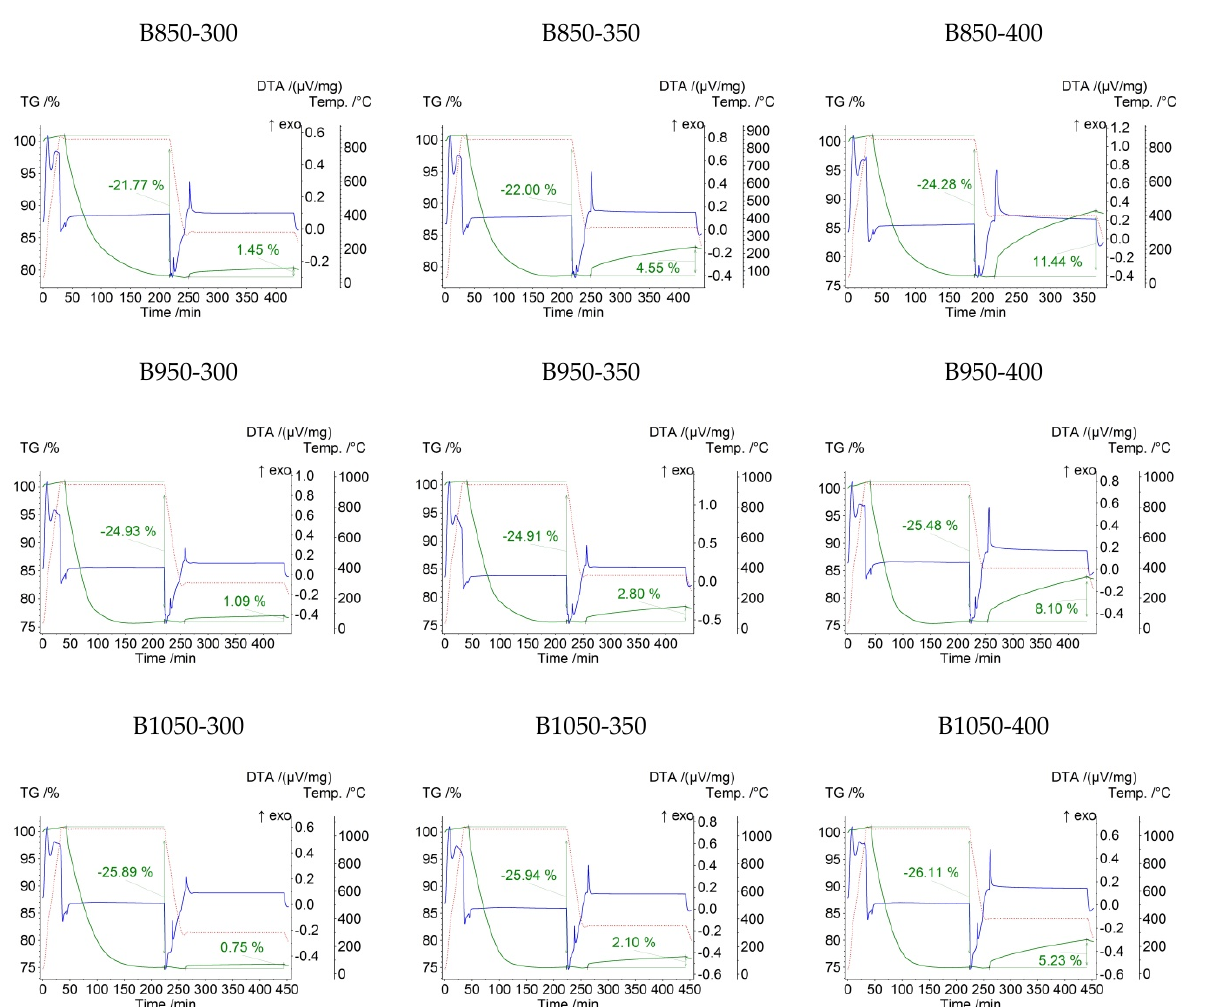
Figure 7. TG/DTA curves recorded during the thermal analysis of ground mill scale (fraction B) subjected to reduction (carbon monoxide) at 850 °C, 950 °C, and 1050 °C, followed by exposure to an oxidizing atmosphere (synthetic air) at temperatures of 300 °C, 350 °C, and 400 °C.